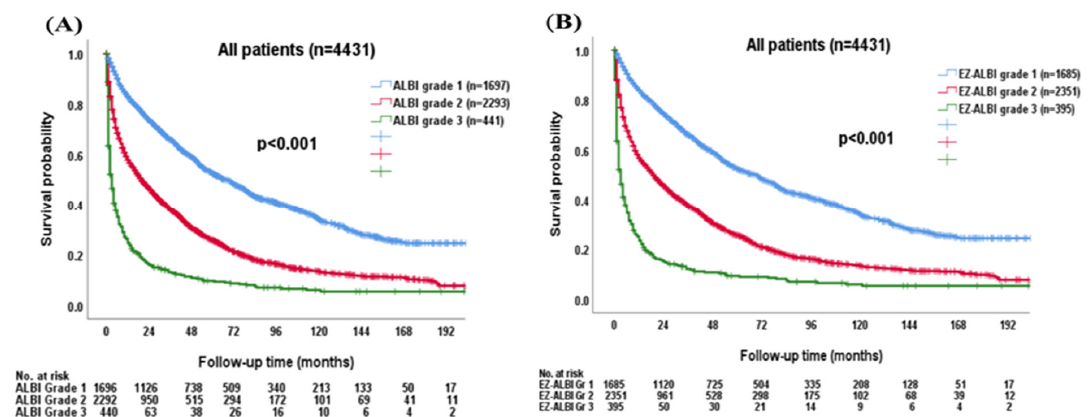
Figure 3. The survival distribution in HCC patients ( n = 4431) according to different ( A ) ALBI grade and ( B ) EZ ‐ ALBI grade. Patients had worse overall survival in both higher ALBI grade and EZ ‐ ALBI grade ( p < 0.001).